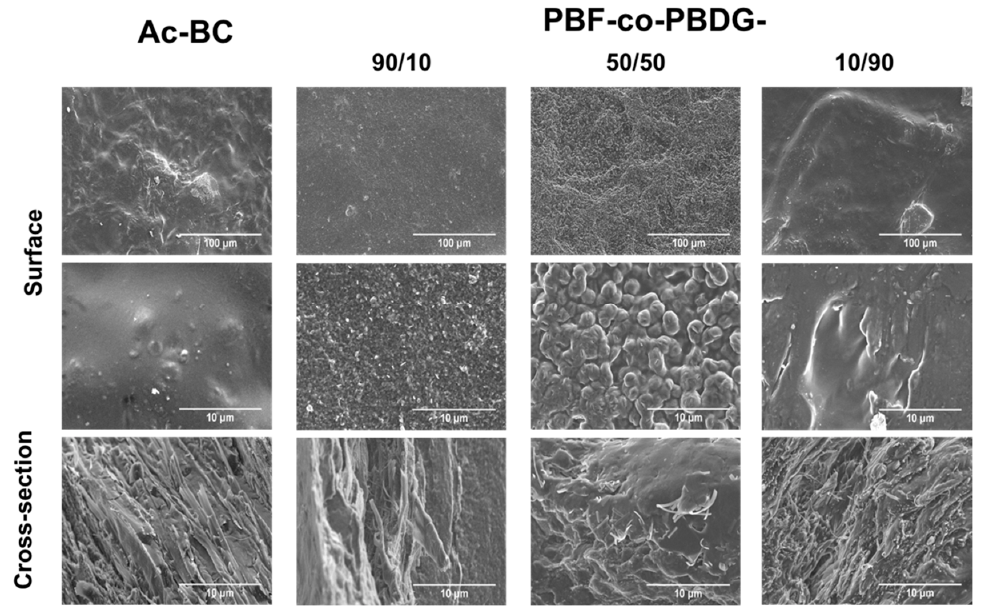
Figure 2. Surface ( top ) and cross-section ( bottom ) SEM micrographs of Ac-BC film and of selected nanocomposite films.